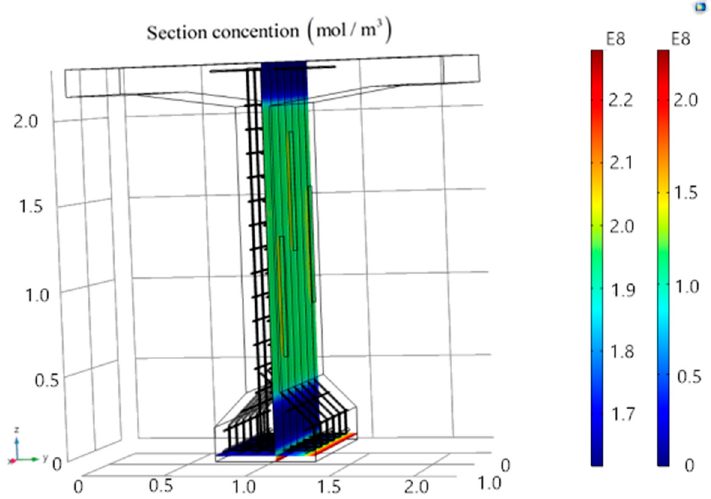
Figure 5. Calculation results of the T-beam model.